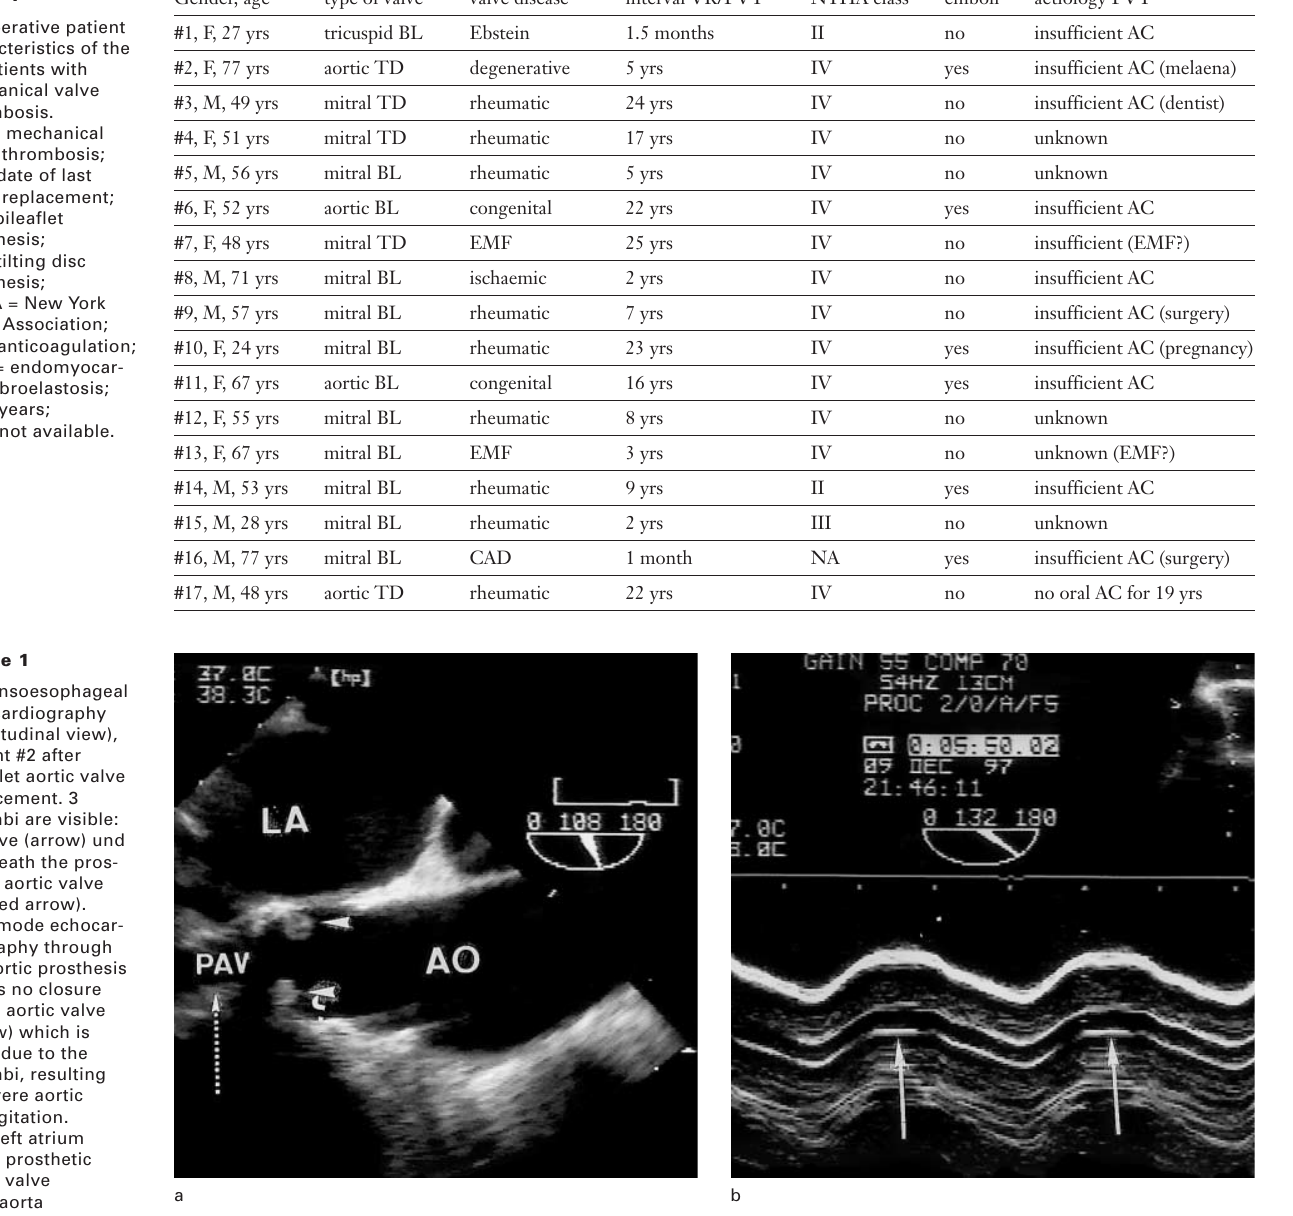
Preoperative patient characteristics of the 17 patients with mechanical valve thrombosis. PVT = mechanical valve thrombosis; VR = date of